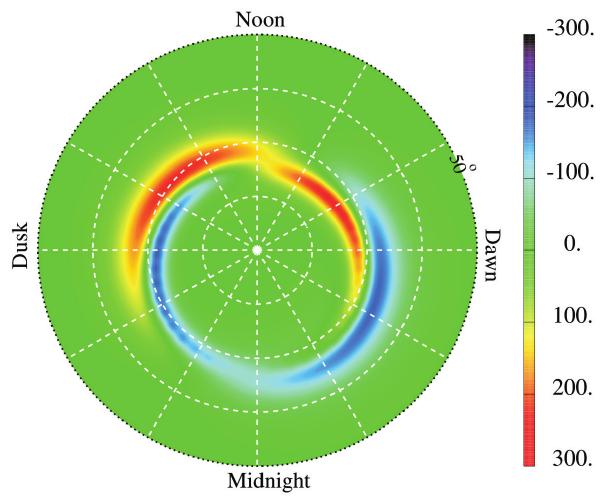
Fig. 6. A sample distribution of model R1 and R2 FAC density (in arbitrary units) at the ionospheric level, obtained using the fast Biot-Savartintegration. Biot–Savart approachwasdevelopedindependentlybyOntiverosetal. (2006)intheirmodeloftheR2FACsand